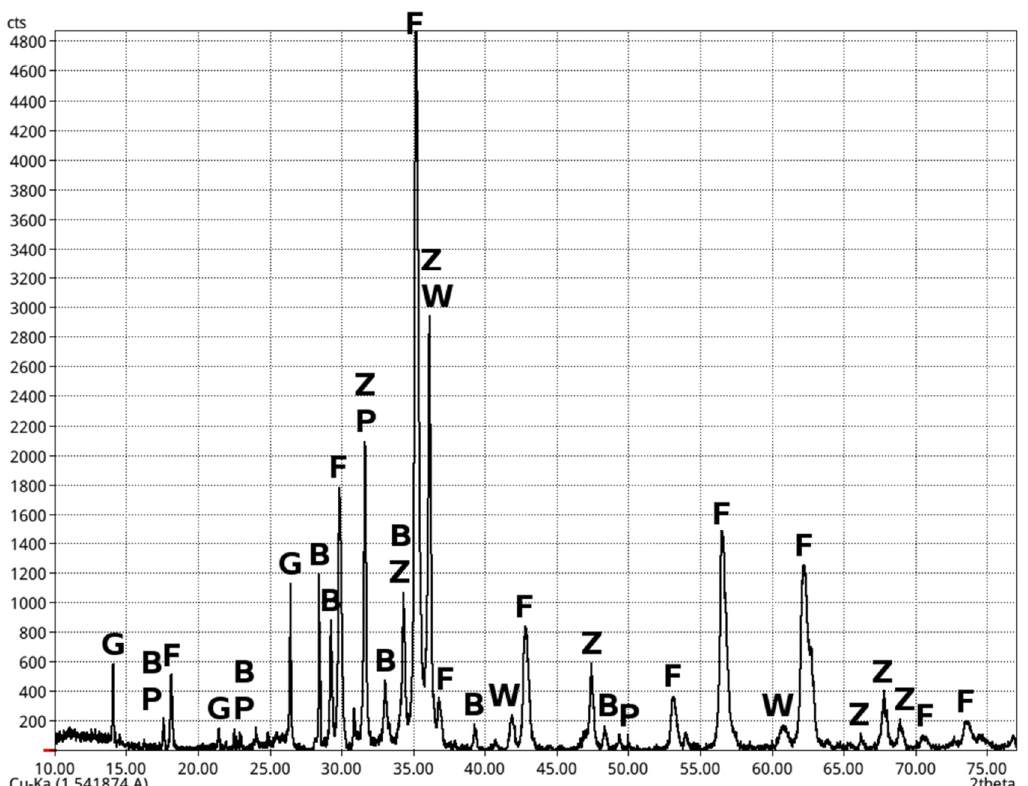
Figure 10. XRD pattern of as-received combustion chamber dusts (B = brownmillerite, F = franklinite, G = goethite, P = plumboferrite, W = wustite and Z = zincite).